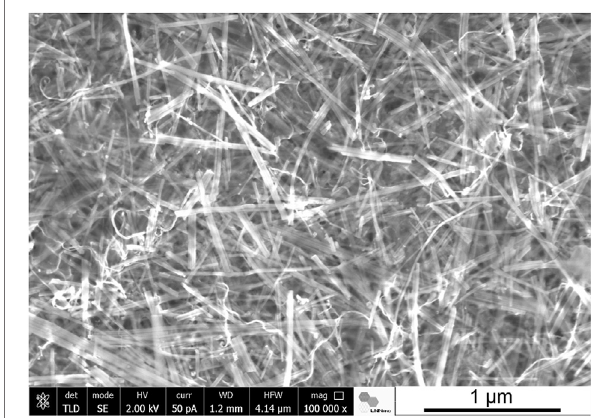
FIGURE 2 | SEM image of a ternary system conformed as a self- supported fi lm based on sepiolite fi bers combined with cellulose nano fi bers andMWCNT(GonzálezdelCampoetal.,2018)(ImagebyJ.Bettini,LNNano- CNPEM, Campinas,